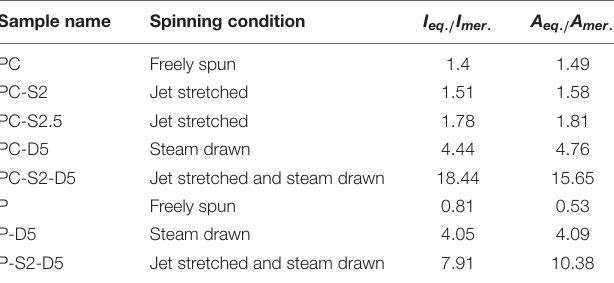
TABLE 4 | Parameters extracted from equatorial ad meridional scans of synchrotron radiation X-ray diffraction patterns of PAN/CNT and PAN fibers spun at different stretching conditions.